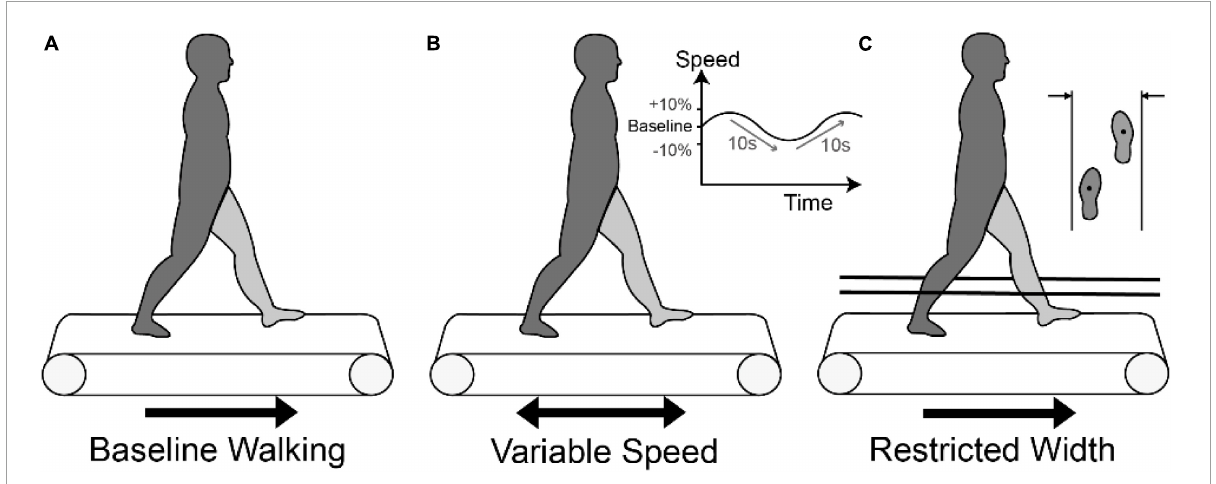
FIGURE1 Three walking conditions: (A) Baseline walking (BW) on a treadmill at self-selected speed, (B) Variable speed walking (VS) condition with the treadmill speed sinusoidally moving between baseline and baseline ± 10% at a frequency of 0.1 Hz, and (C) Restricted width (RW) condition with strings placed at 46